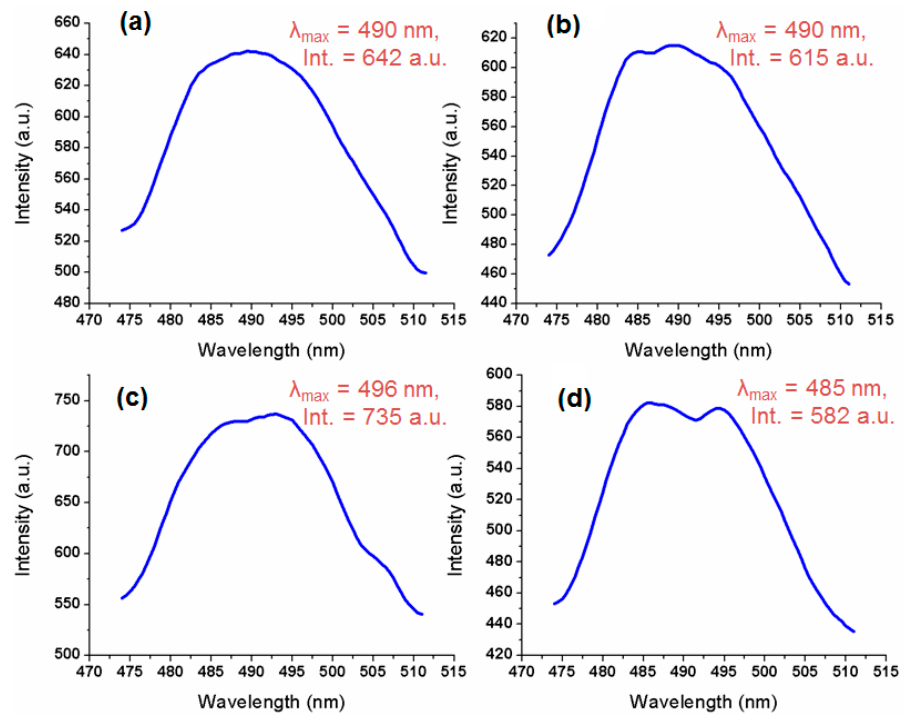
Figure 5. Fluorescence spectra of ( a ) Sm-FAp/Glutamic acid; ( b ) Sm-FAp/Aspartic acid; ( c ) Sm-FAp/Glycine; ( d ) Sm-FAp/Histidine.